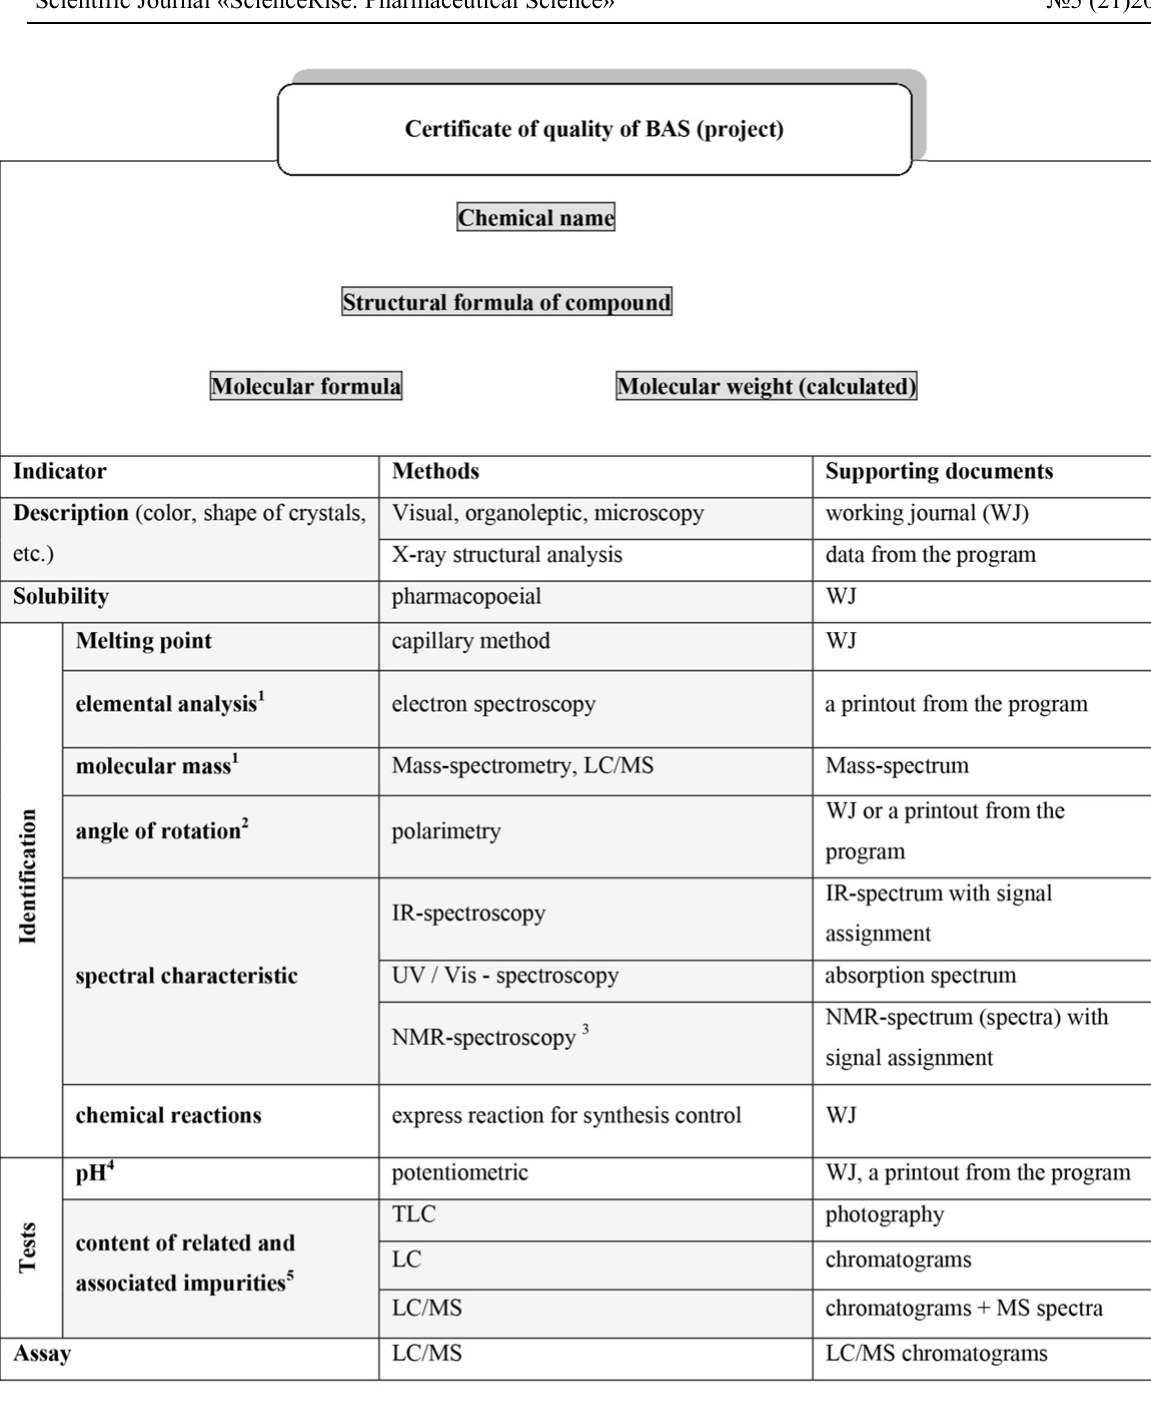
Fig. 2. The structure of the "certificate of quality" of the newly synthesized substance for transfer for primary pharmacological screening (mandatory tests are marked with gray): 1 one of two indicators is enough; 2 for optically active substances; 3 must be at least 1 H NMR; 4 for soluble substances with predicted basic or acidic properties; 5 one of the listed